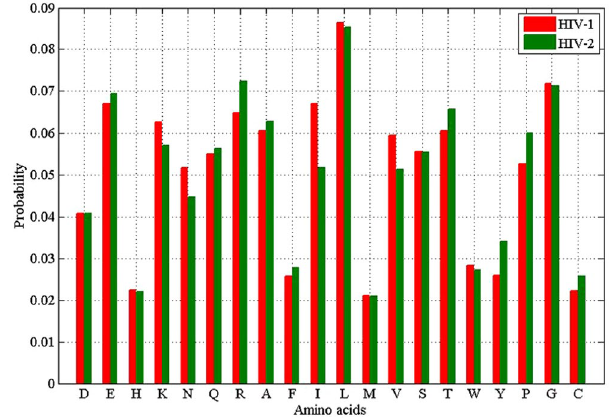
Figure 1. Amino acid frequencies of each amino acid in two HIV